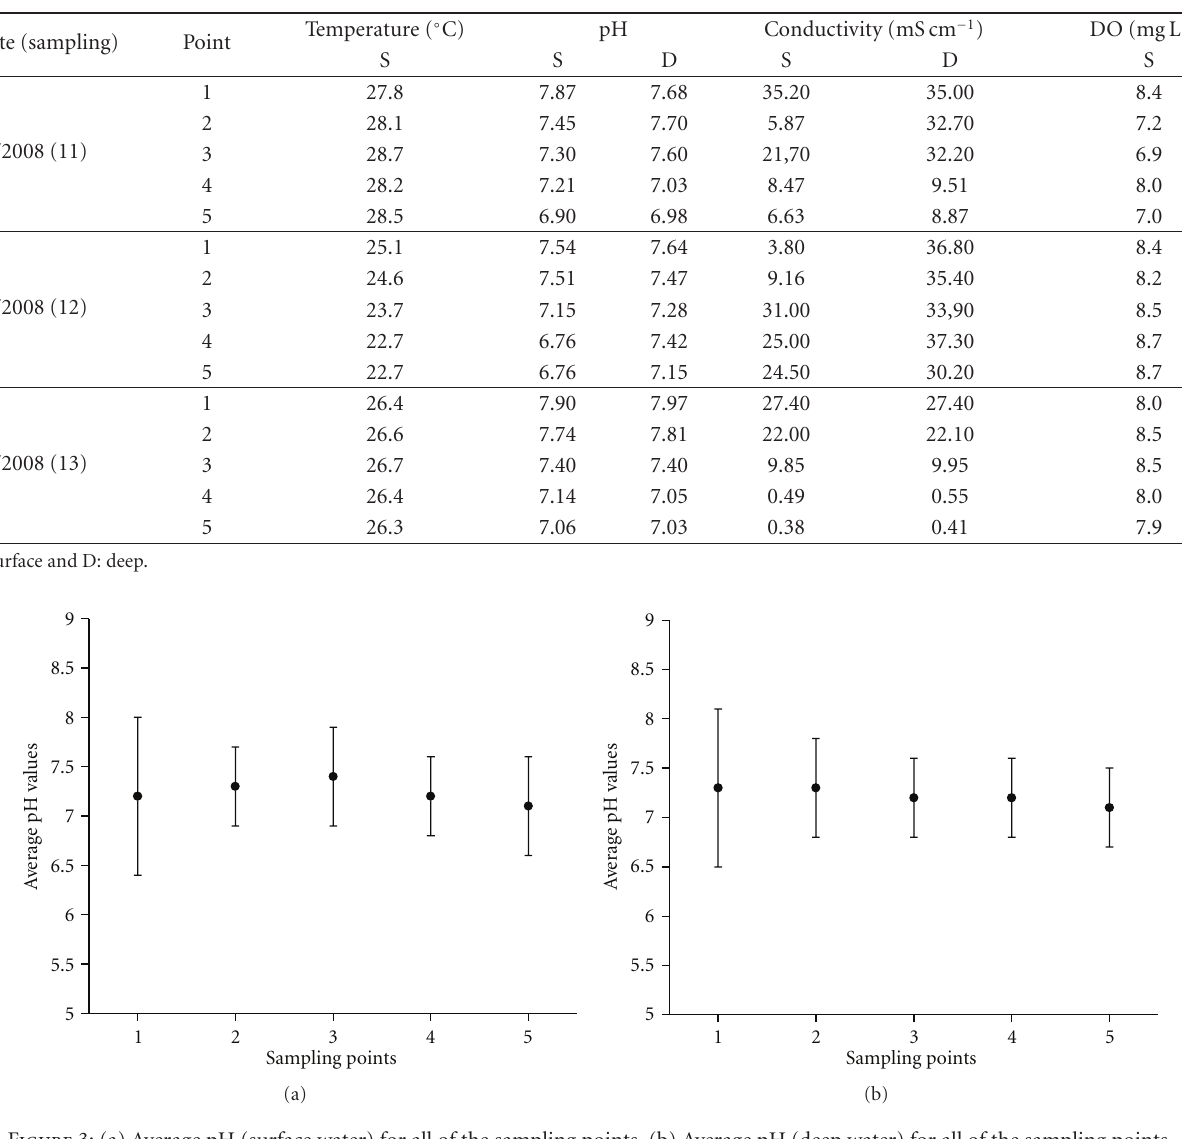
Figure 3: (a) Average pH (surface water) for all of the sampling points. (b) Average pH (deep water) for all of the sampling